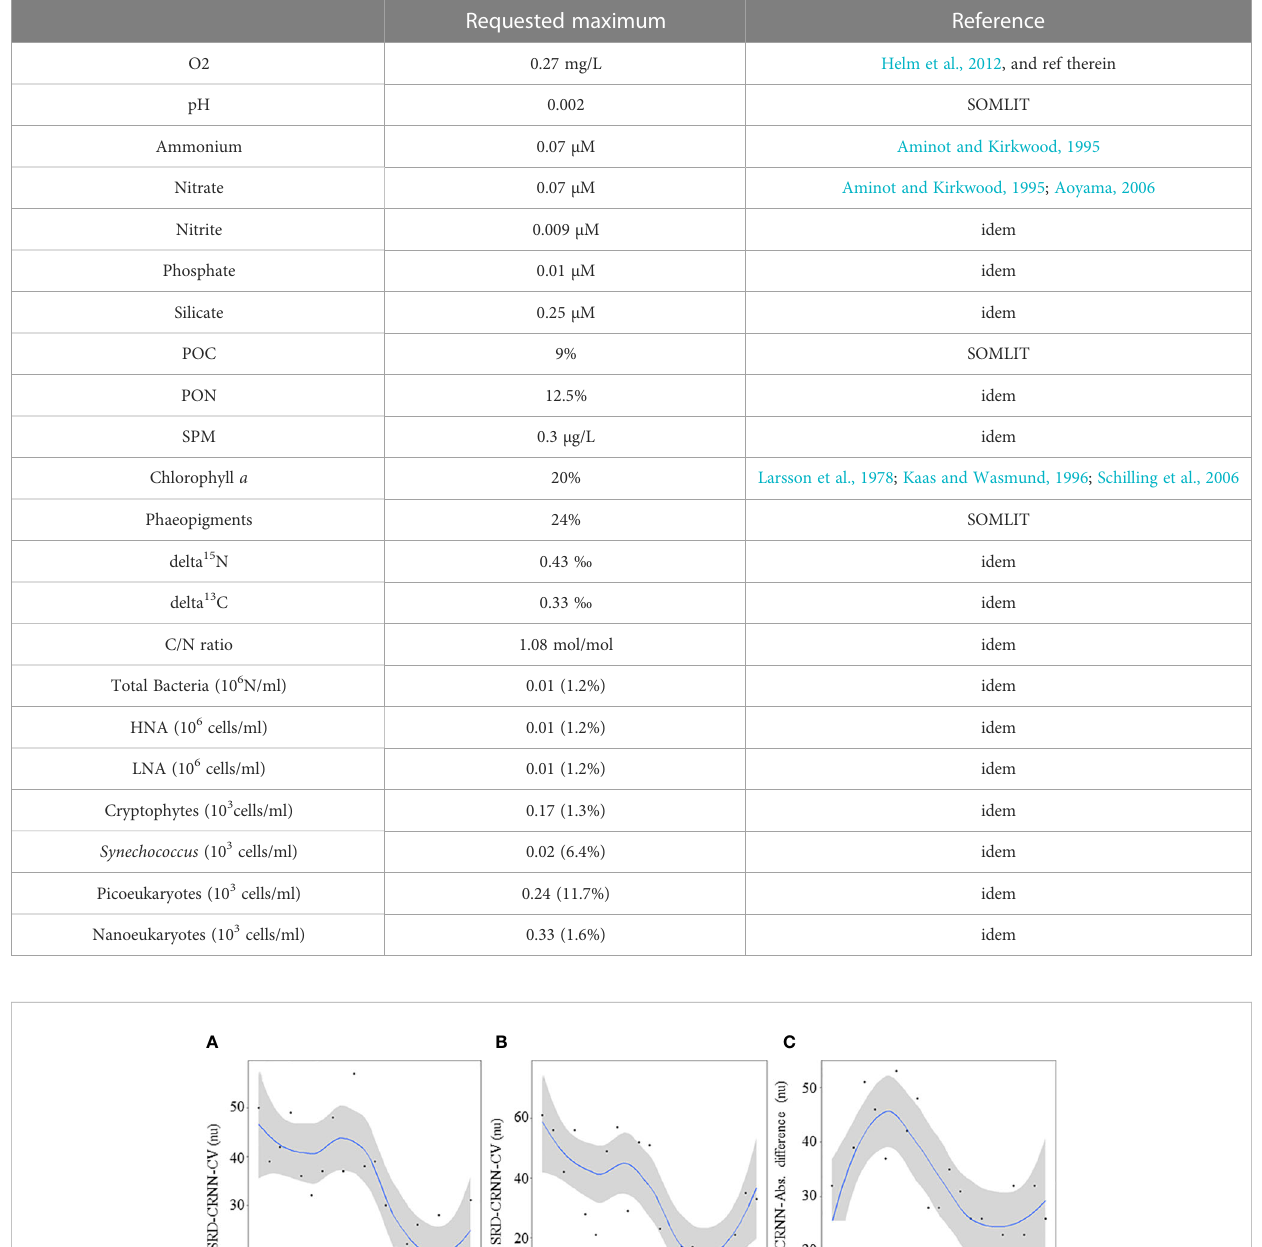
TABLE 3 Reproducibility targets and reference used to calculate the overall performance of the participating laboratories to the inter-laboratory comparison exercises of the SOMLIT